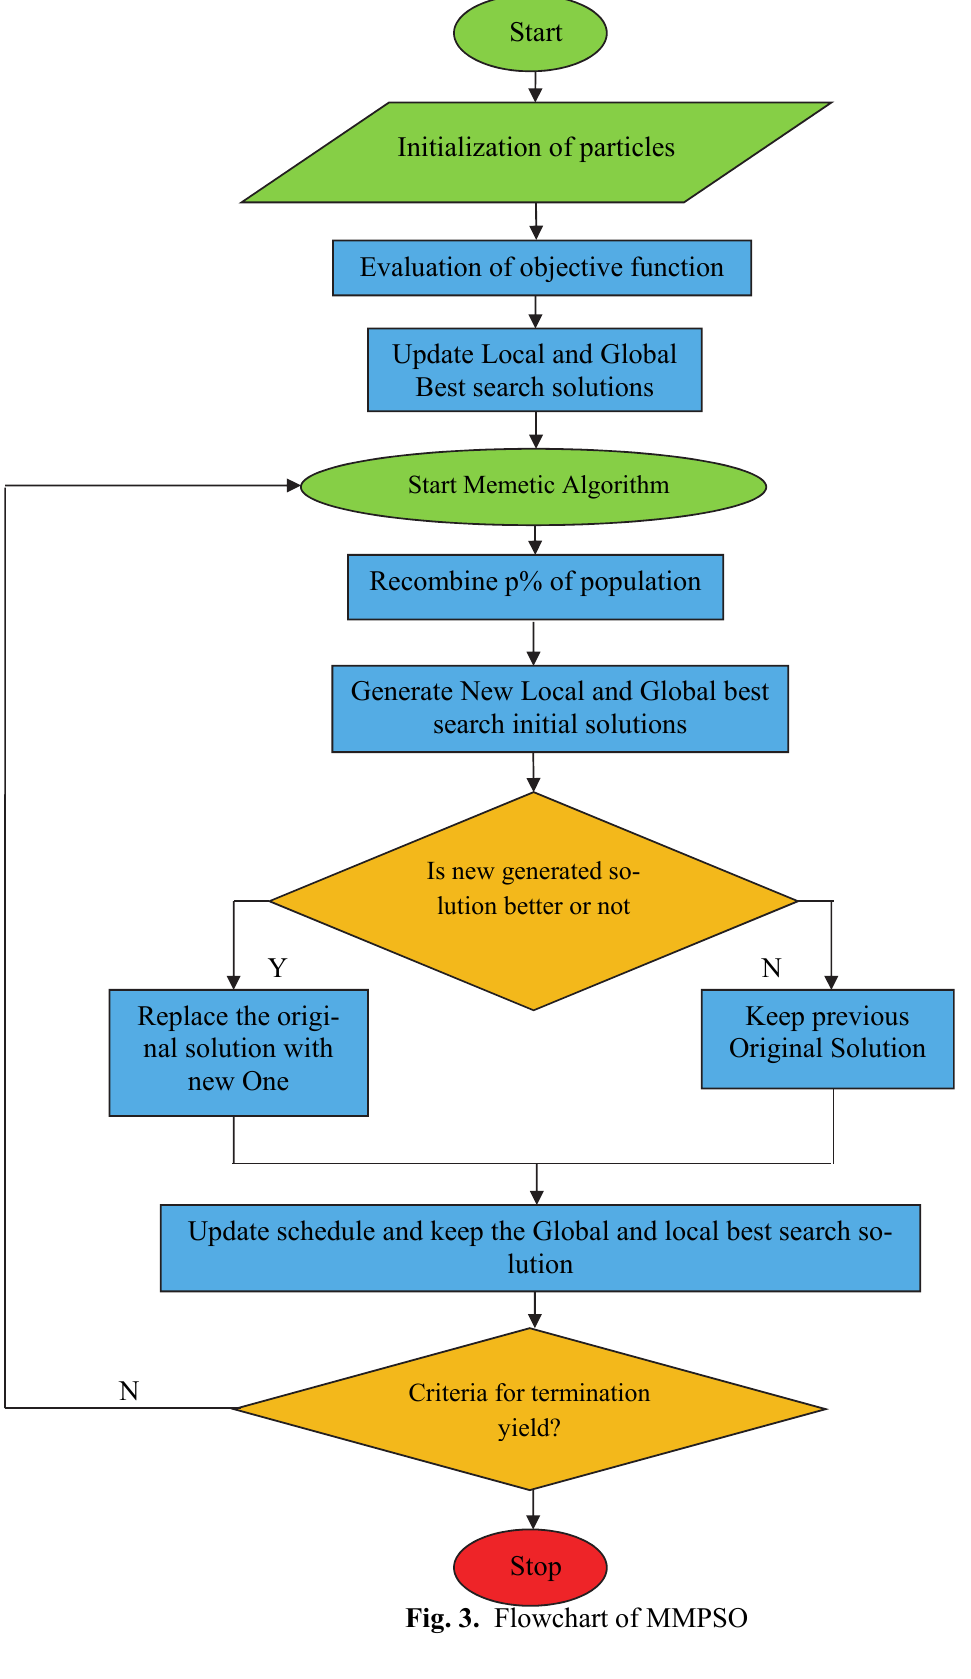
Fig. 3. Flowchart of